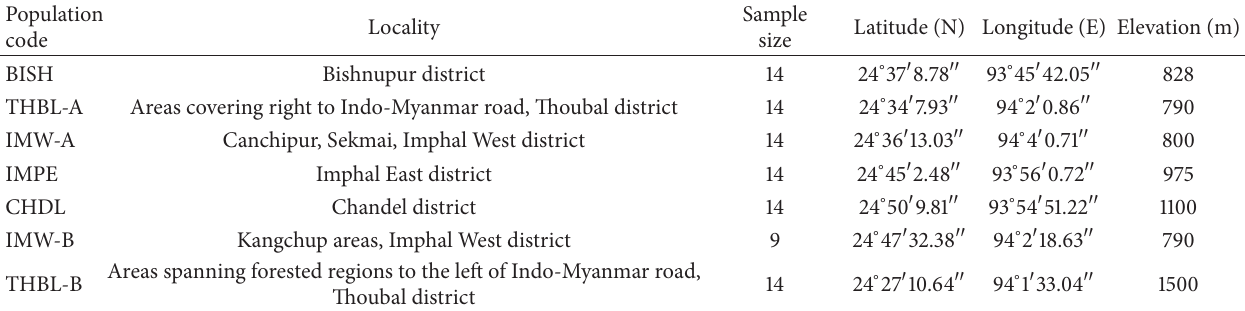
Table 1: Location of sample collection and sample size for seven populations of M. baccifera in the present study.